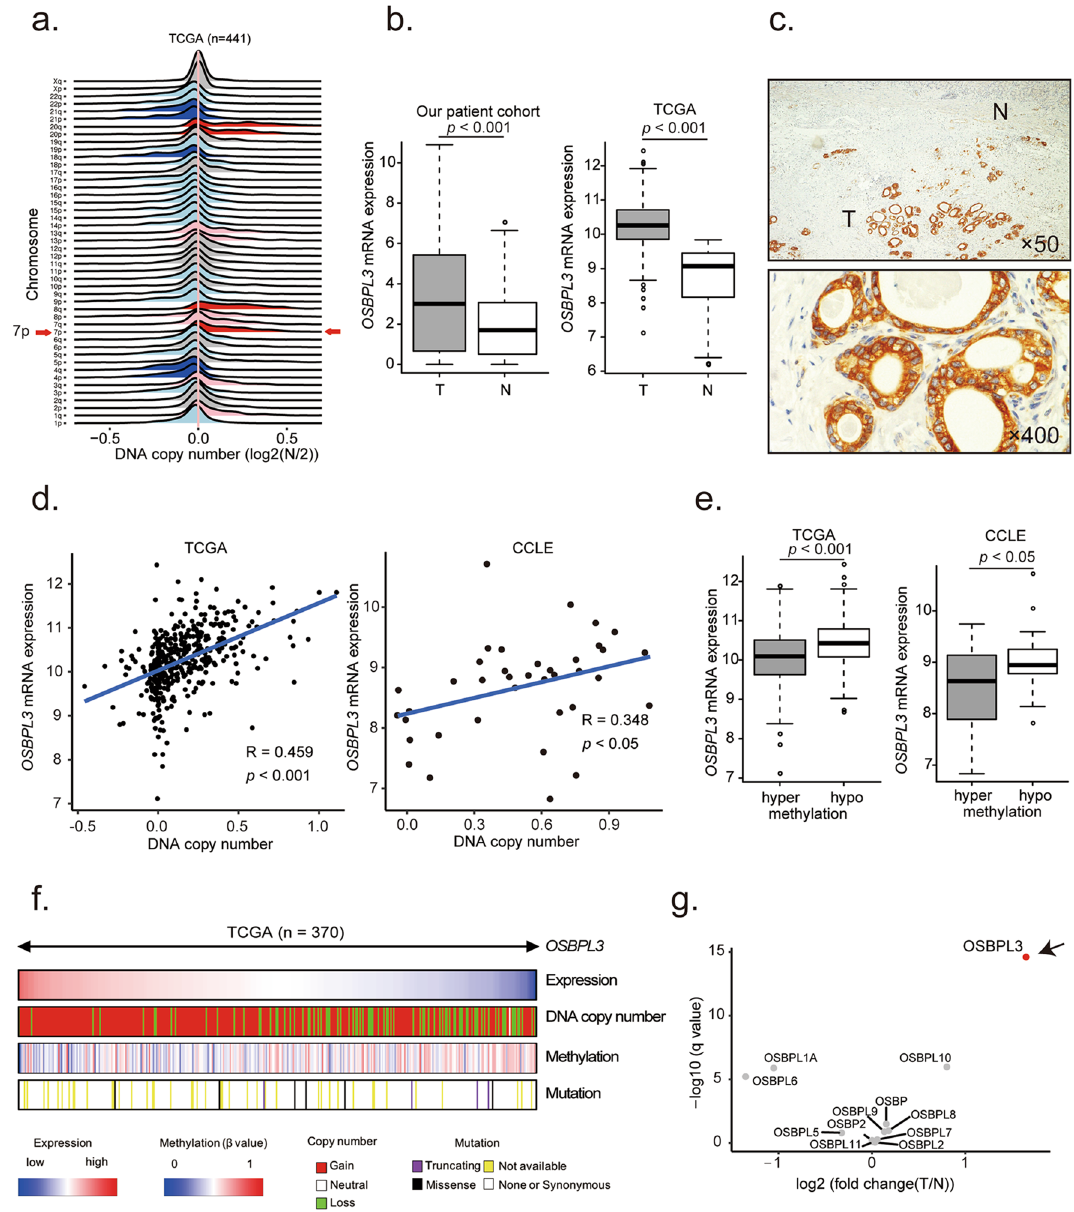
Figure 1. OSBPL3 expression, DNA copy number, and promoter methylation in GC. ( a ) DNA copy number variations according to chromosome arm in 441 GC tissues from TCGA. ( b ) OSBPL3 mRNA expression in 109 tumor tissues and 109 paired normal tissues from our GC patient cohort (left panel) and in 415 tumor tissues and 35 normal tissues from GC patients in TCGA (right panel). T: tumor tissue; N: normal tissue. Mann– Whitney U test. ( c ) Immunohistochemical analysis of OSBPL3 in representative samples from our GC patient cohort. Original magnification, × 50 (upper) and ×400 (lower). T: tumor tissue; N: normal tissue. ( d ) Correlation between OSBPL3 mRNA expression and DNA copy number (log 2(N/2)) in 413 GC patients from TCGA and 38 GC cell lines from the CCLE. ( e ) OSBPL3 mRNA expression in 185 GC patients exhibiting OSBPL3 promoter hypomethylation and 185 GC patients exhibiting OSBPL3 promoter hypermethylation from TCGA (left panel). OSBPL3 mRNA expression in 17 GC cell lines exhibiting OSBPL3 promoter hypomethylation and 17 GC cell lines exhibiting OSBPL3 promoter hypermethylation from the CCLE (right panel). Mann–Whitney U test. ( f ) An integrated view of the mRNA expression, DNA copy number, promoter methylation, and mutation profiles of OSBPL3 in 370 GC cases from TCGA. The samples are sorted according to the OSBPL3 mRNA expression level. ( g ) The mRNA expression levels of OSBP family members in 415 tumor tissues compared with 35 normal tissues of GC patients from TCGA. Mann–Whitney U test and FDR-controlling procedures were